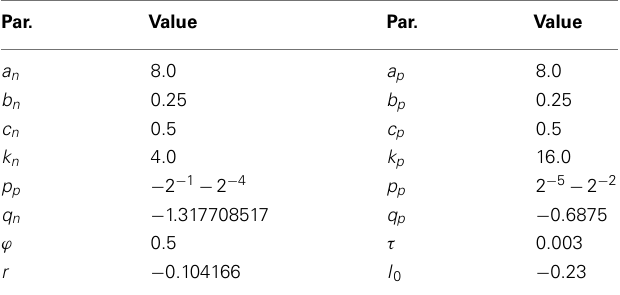
Table 2 | Parameters for Class II mode.